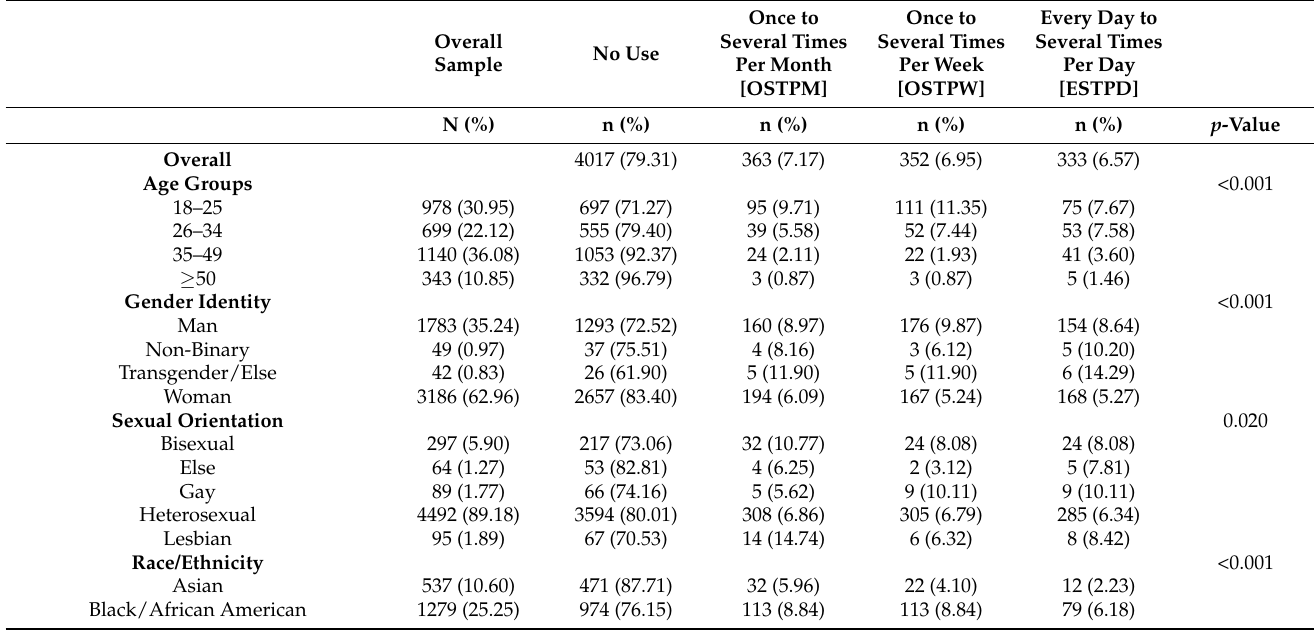
Table 1. Descriptive and bivariate analyses of the past-month e-cigarette use characteristics by sociodemographic characteristics, the likelihood of contracting COVID-19, social interaction, mental health symptoms, and substance use (N =